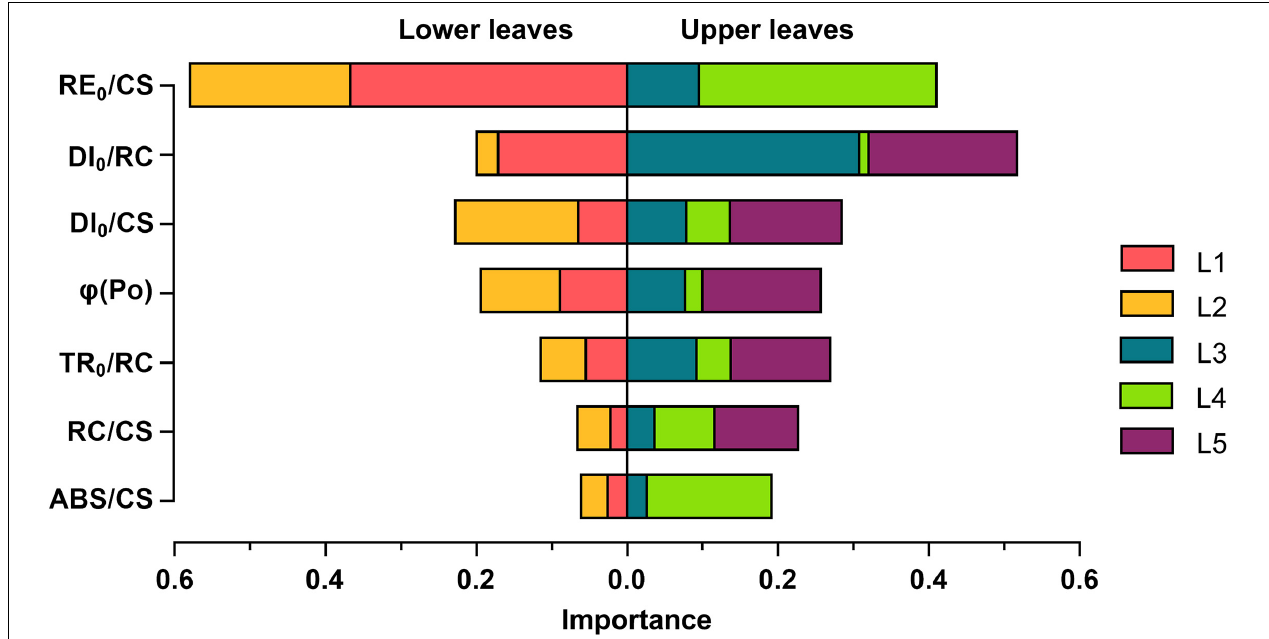
FIGURE 6 | Contribution of the JIP parameters to the Chl content estimation of each vertical leaf layer based on the XGboost tree regression model and the cumulative feature importance of the lower leaves vs. the upper leaves. L1-L5 represent the leaf position from bottom to top of the plant.